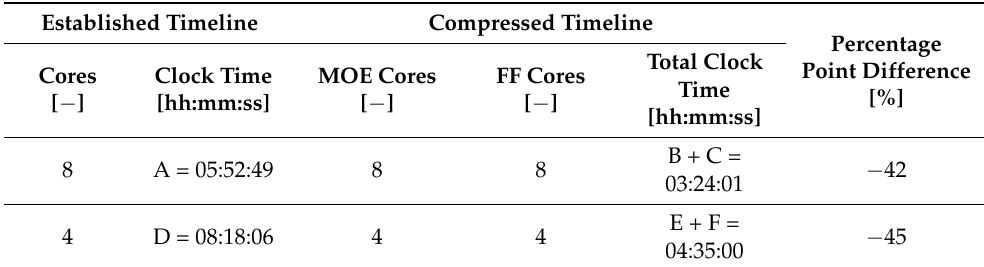
Table 12. Comparison of the total wall-clock time for the established and compressed timeline approaches. Notation aligns with Table